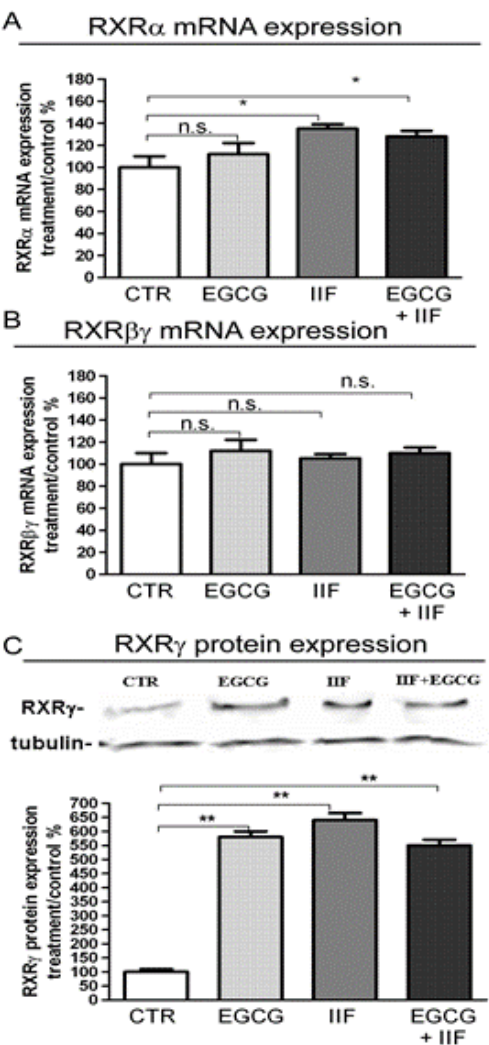
Figure 2. RAR α β and γ mRNA expression and RXR γ protein expression in BE(2)-C neuroblastoma cells. Cells were treated with 20 µ g/mL l EGCG and 10 µ M 6-OH-11-O-hydroxyphenanthrene (IIF), individually and in combination for 24 h. RXR α ( A ) and RXR βγ ( B ) mRNA expression as detected by qPCR in control (CTR) and treated samples. ( C ) RXR γ protein expression. Proteins (50 µ g) from total cell lysates were subjected to SDS–PAGE and Western blot analysis. The values were normalized to the untreated controls. β -tubulin was used as a loading control. The results are expressed as the average ± SE of three independent experiments. * p < 0.05; ** p < 0.01. n.s.: not significant.